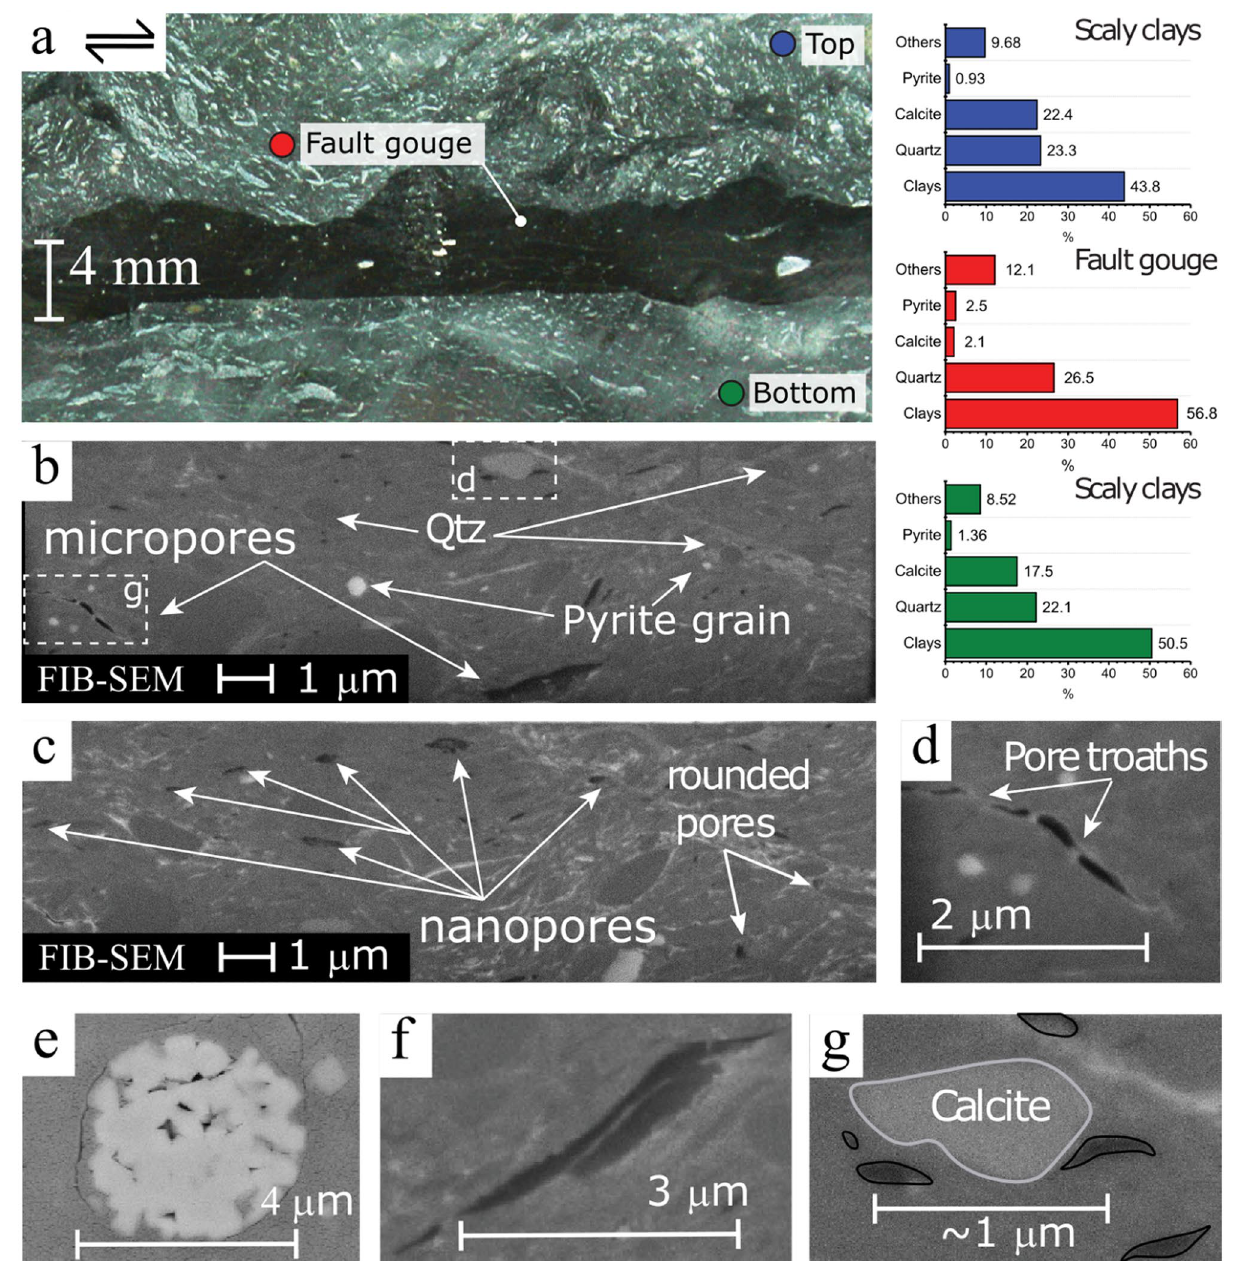
Figure 3. Microstructures of the fault gouge. ( a ) A cm-scale photograph of the fault gouge (black) recovered from borehole BFS-2. The thickness of the gouge varies from 3 to 10 mm, and it is surrounded by calcite- enriched scaly clays. On the right, three graphs showing the different mineralogical composition of the gouge and its surroundings. ( b ) Selected FIB-SEM image of the fault gouge showing micropores. White boxes show the position of figures ( d ) and ( g ). The image also shows rounded quartz minerals, isolated pyrite grains and rare presence of calcite. ( c ) Selected FIB-SEM image of the fault gouge showing sub-rounded and sub- angular nanopores aligned in the direction of shearing. Isolated rounded pores are also present ( d ) Thin and elongated micropores connected in 3D by pore throats. ( e ) SEM images of framboid pyrite with porosity in the single pyrite grains. ( f ) FIB-SEM image of angular or jagged micropores connected in 3D by pore throats. ( g ) Nanopores possibly connected by pore throats situated near a calcite grain boundary i.e., pore-grain bridge complex. Images ( E ) and ( F ) were obtained from other sections of the